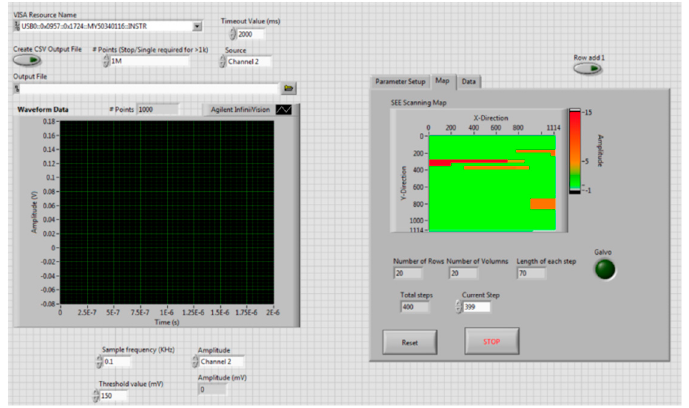
Figure 13. User interface of the mapping program for amplifier testing.